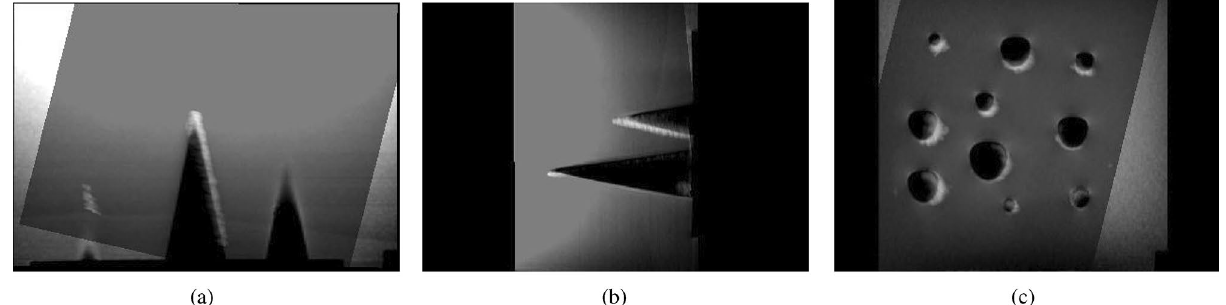
Figure 6. Overlaid images from the axial ( a ), sagittal ( b ) and coronal ( c ) planes with the registered MRI and ab-3D-US images of the multi-cone phantom. The cones are black in the MR image and the white in the US image. For this registration the TRE was